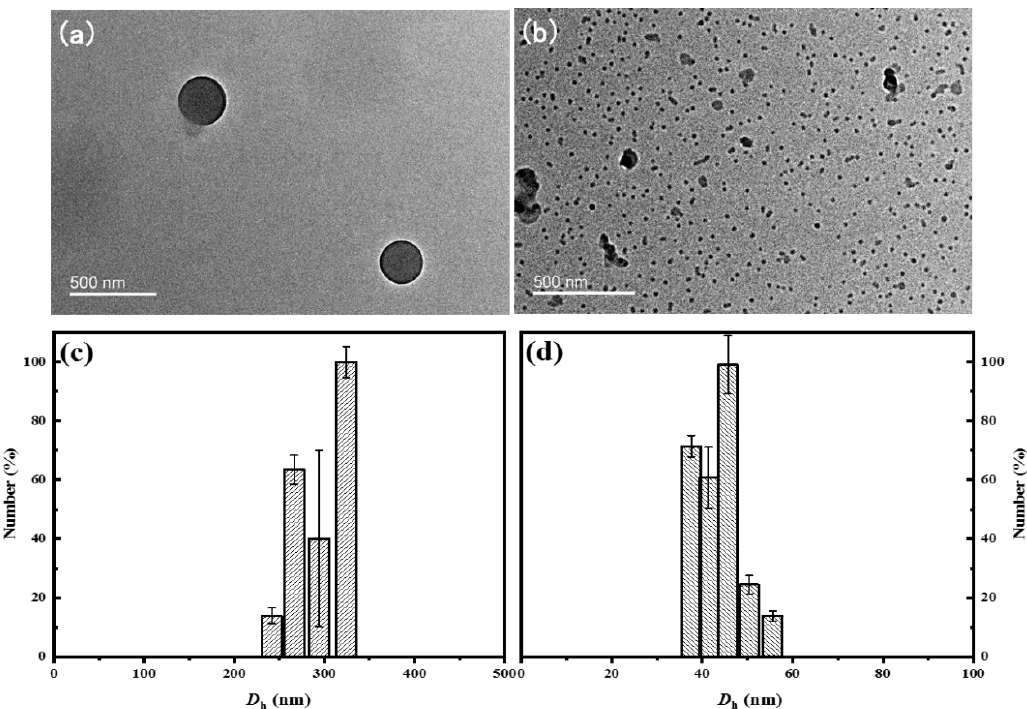
Figure 4. The Transmission electron microscopy (TEM) images of PEG- b -PNSN 8 - co -PNPE 28 with non-irradiation ( a ) and with 10 h irradiation ( b ); the D h with non-irradiation ( c ), and with 10 h irradiation ( d ) in aqueous solution.